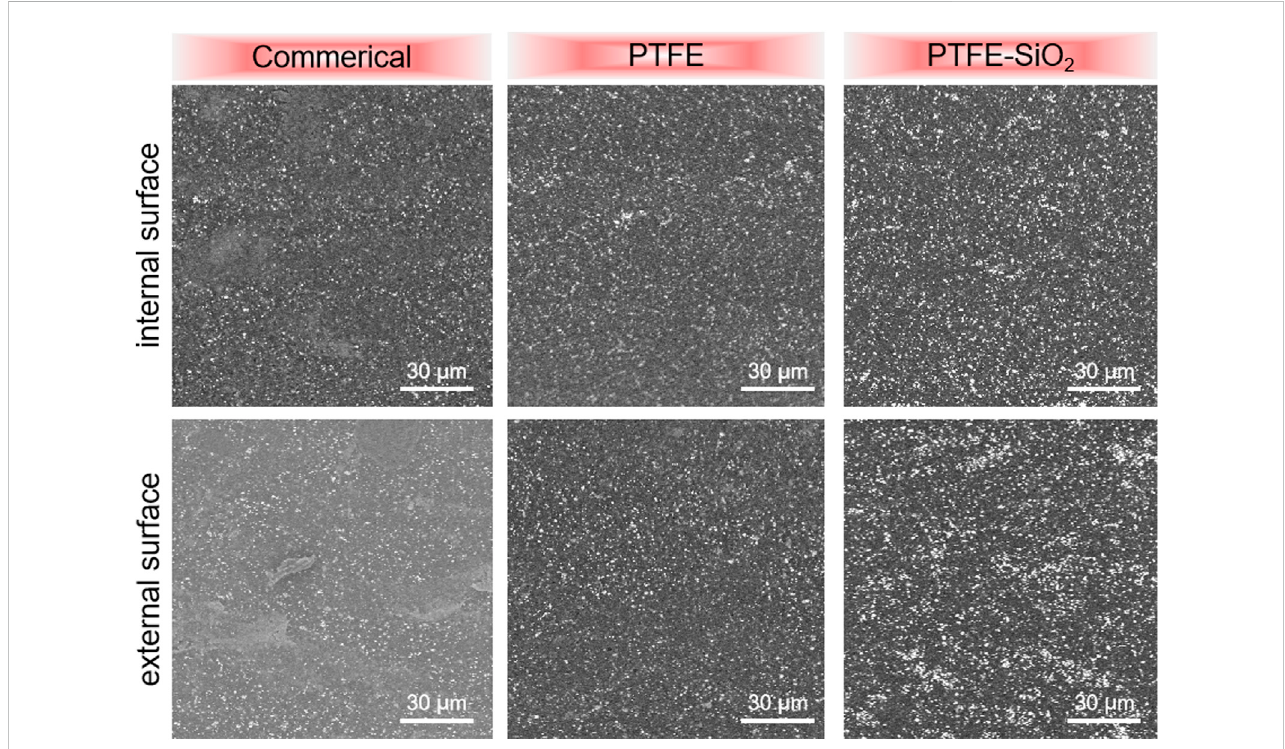
The suefaces SEM images of commerical catheter, PTFE catheter, and PTFE-SiO 2 catheter,